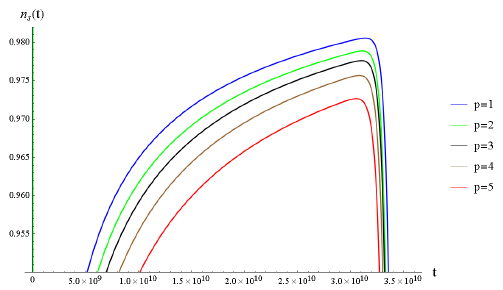
Figure 6. Detail of scalar spectral